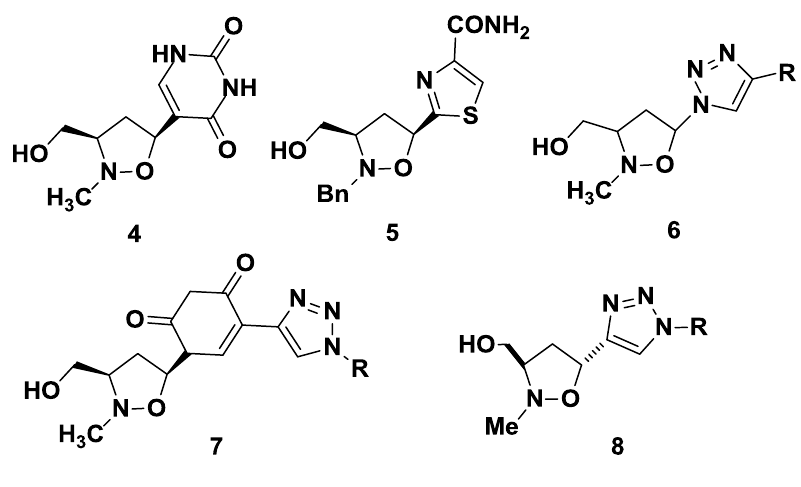
Figure 3. Examples of N,O